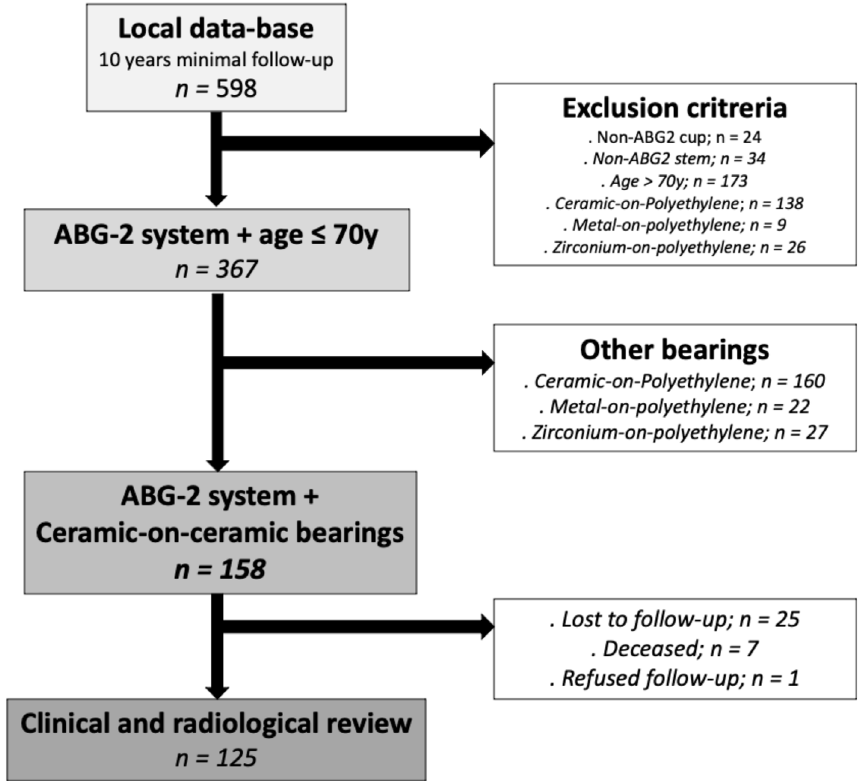
Figure 1. Participant fl